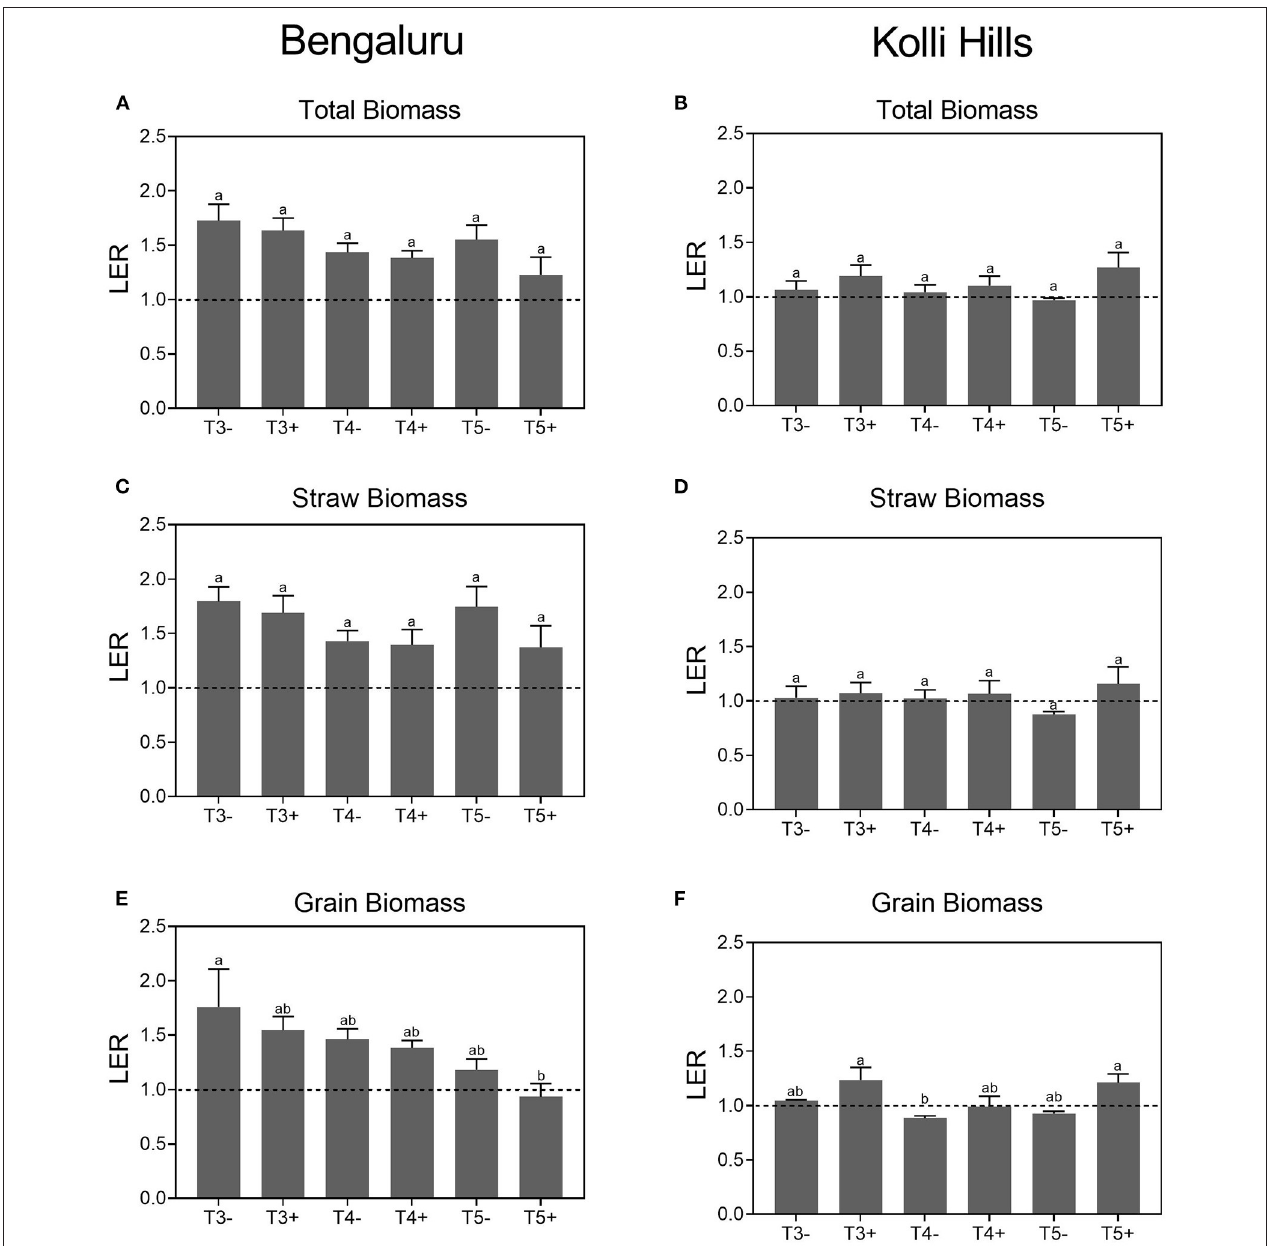
FIGURE 5 | Land equivalent ratio (LER) of total grain yield in different intercropping treatments during 2017/18 at the Bengaluru (A,C,E) and Kolli Hills (B,D,F) sites. Bars represent the average of four replicates with standard error of mean. Tukey‘s test (one-way ANOVA) was used for multiple comparison, separately for each site, and values with same letters are not significantly different from each other at p >